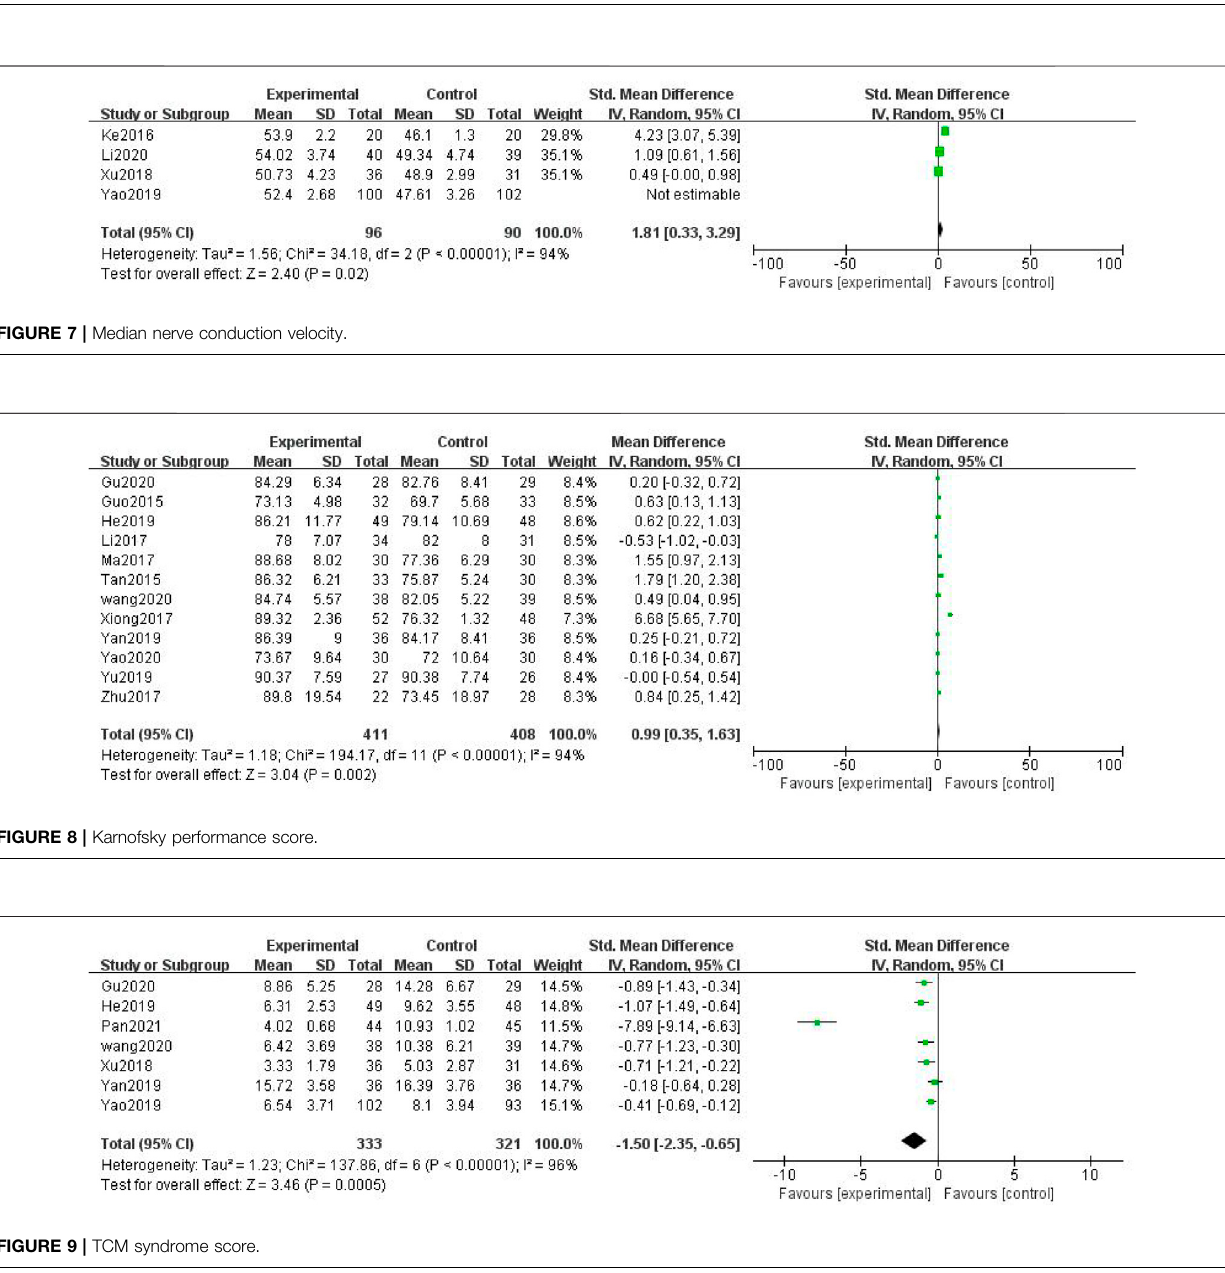
FIGURE 6 | Peroneal nerve conduction velocity.